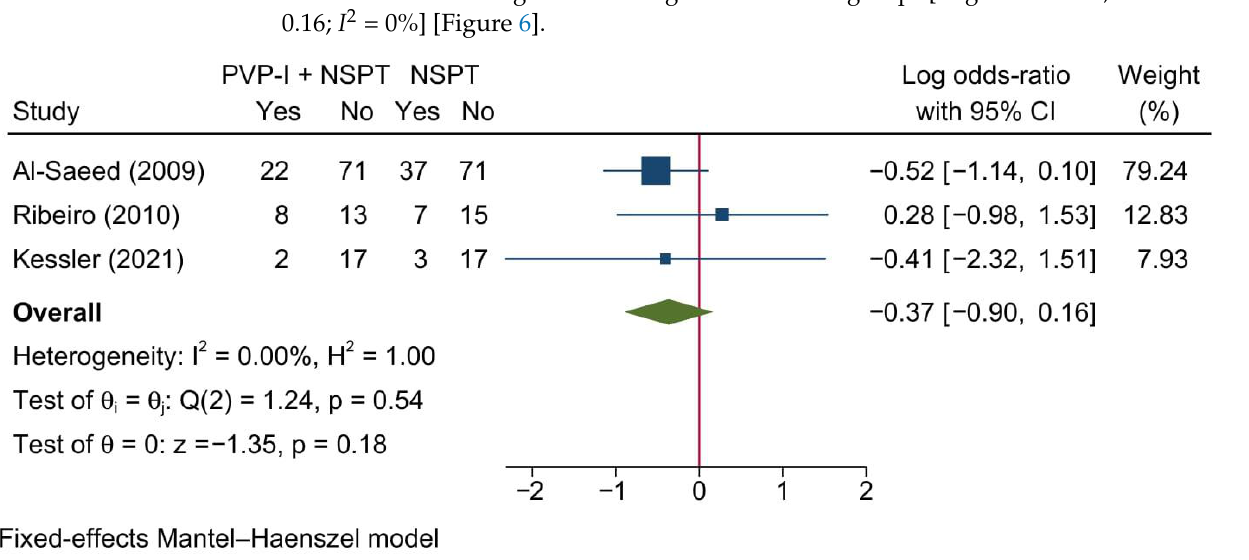
Figure 5. Forest plot showing the comparison between PVP-I + NSPT and NSPT alone regarding relative horizontal attachment level [31,46].